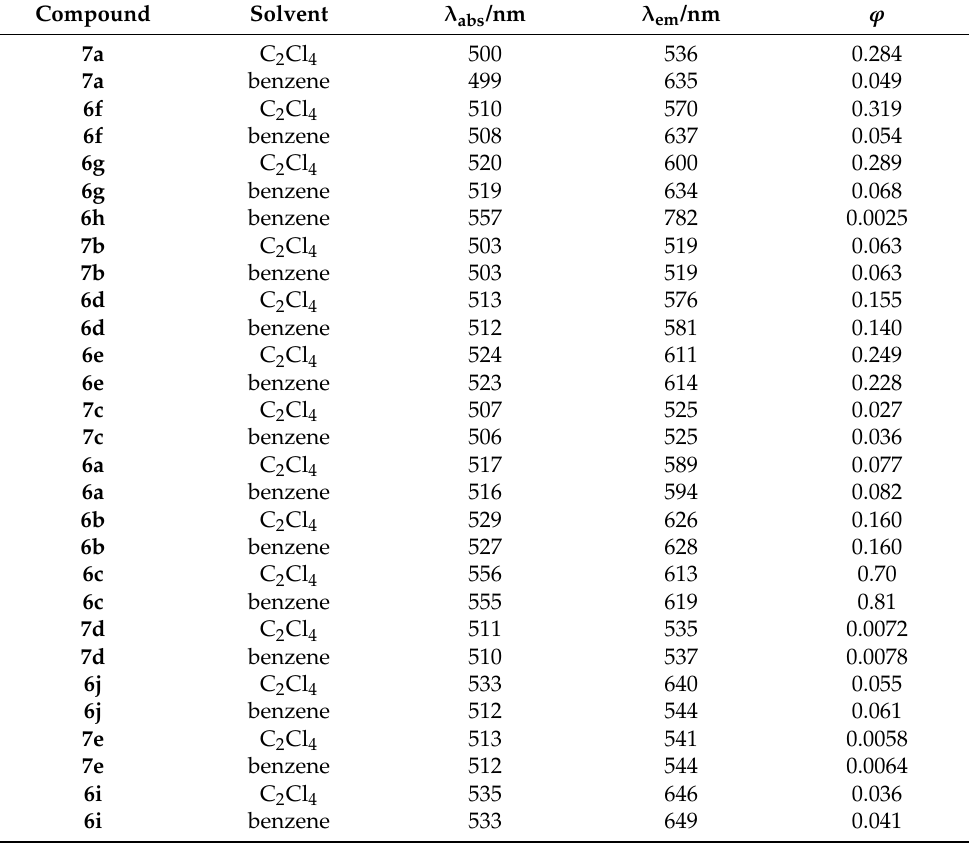
Table 4. The photophysical properties of the synthesized dyes in tetrachlorethylene and benzene: the position of the long-wavelength peak of the absorption spectrum λ abs , the position of the peak of the luminescence spectrum λ em , the quantum yield of luminescence ϕ .